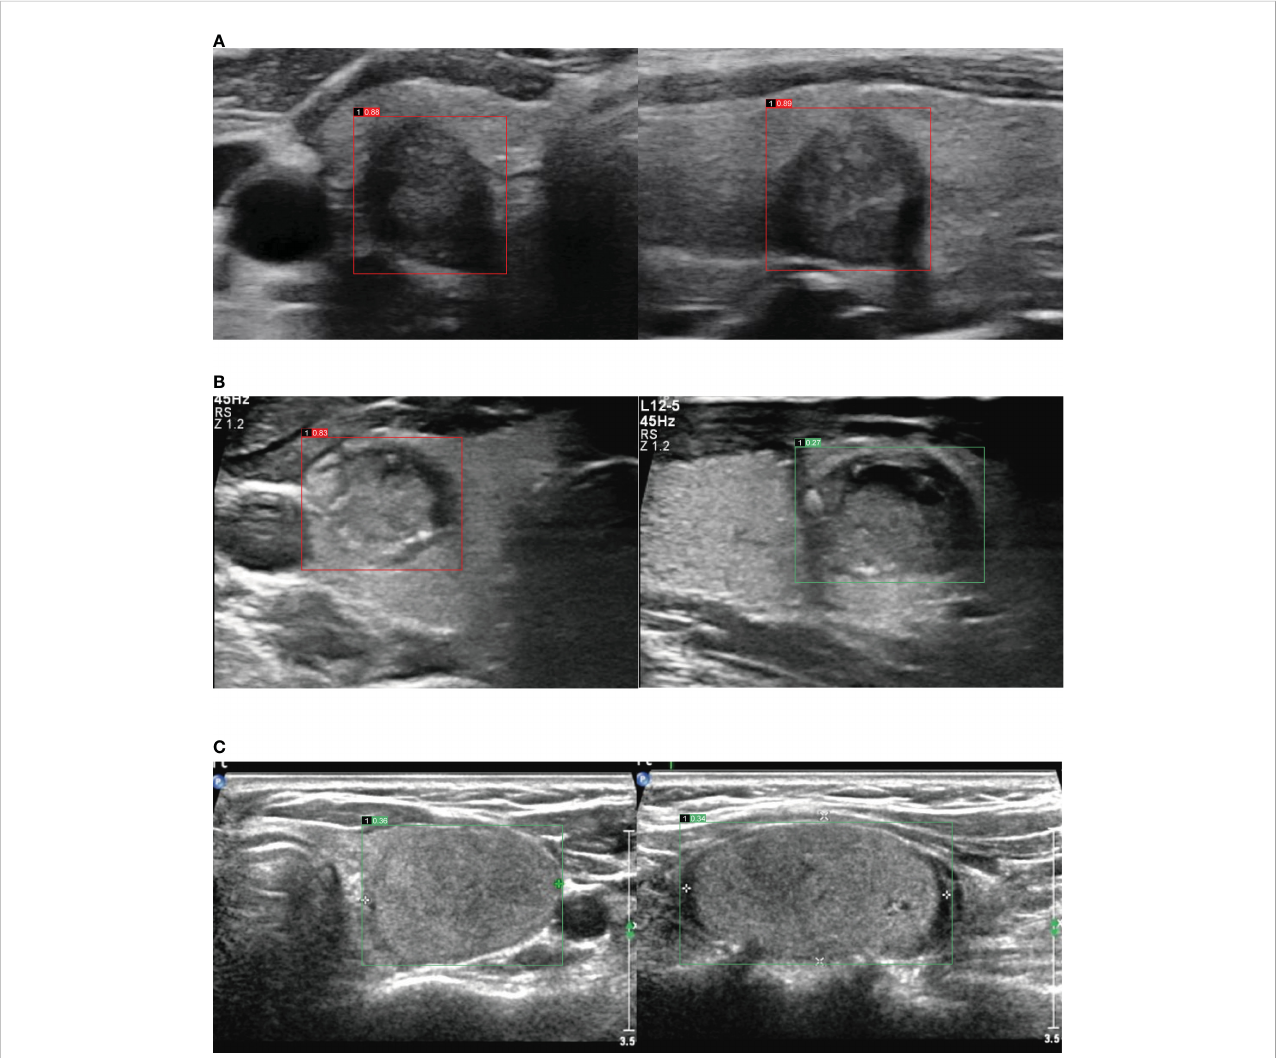
FIGURE 2 (A) Images in a 60-year-old woman with papillary thyroid carcinoma in the right lobe of thyroid, image of transverse section (the left), malignant risk score is 0.88, suggests malignant, image of longitudinal section (the right), malignant risk score is 0.89, suggests malignant. (B) Images in a 34-year-old man with papillary thyroid carcinoma in the right lobe of thyroid, image of transverse section (the left), malignant risk score is 0.83, suggests malignant, image of longitudinal section (the right), malignant risk score is 0.27, suggests benign. (C) Images in a 57-year-old woman with follicular thyroid adenoma in the left lobe of thyroid, image of transverse section (the left), malignant risk score is 0.36, suggests benign, image of longitudinal section (the right), malignant risk score is 0.34, suggests